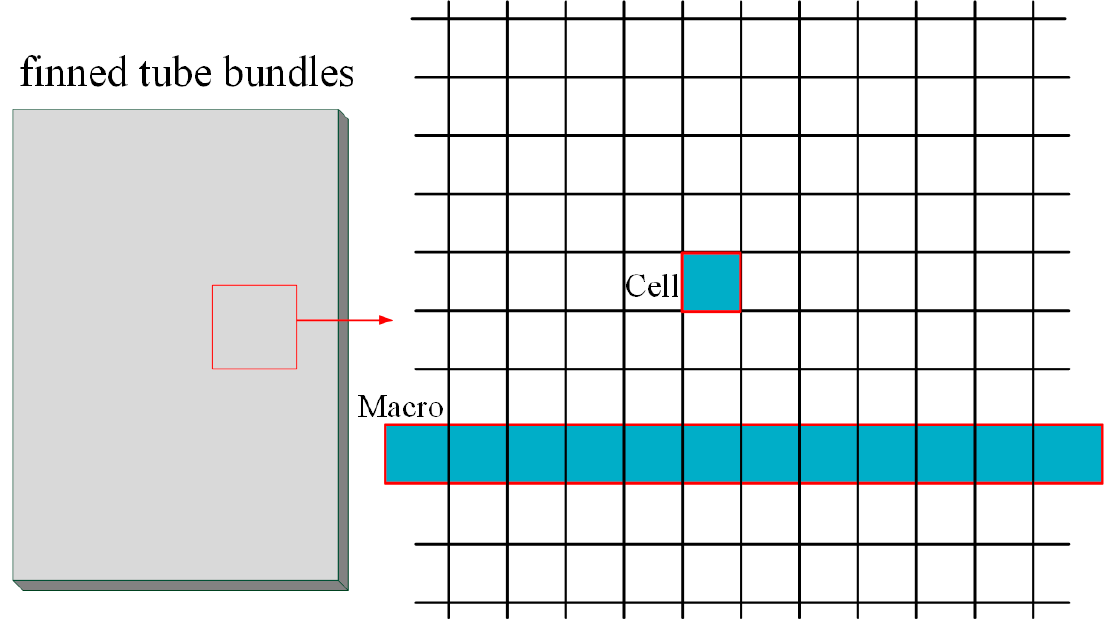
Figure 2. Schematics of cells and macros.